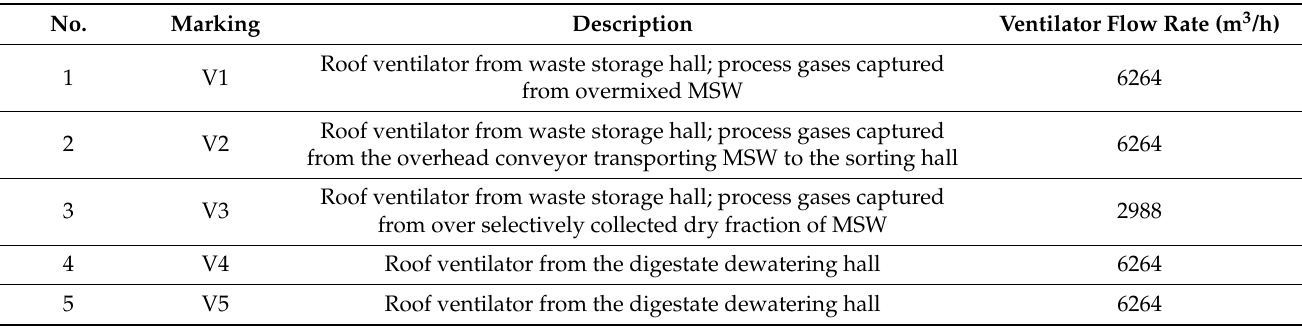
Table 3. Measurement points characteristics.